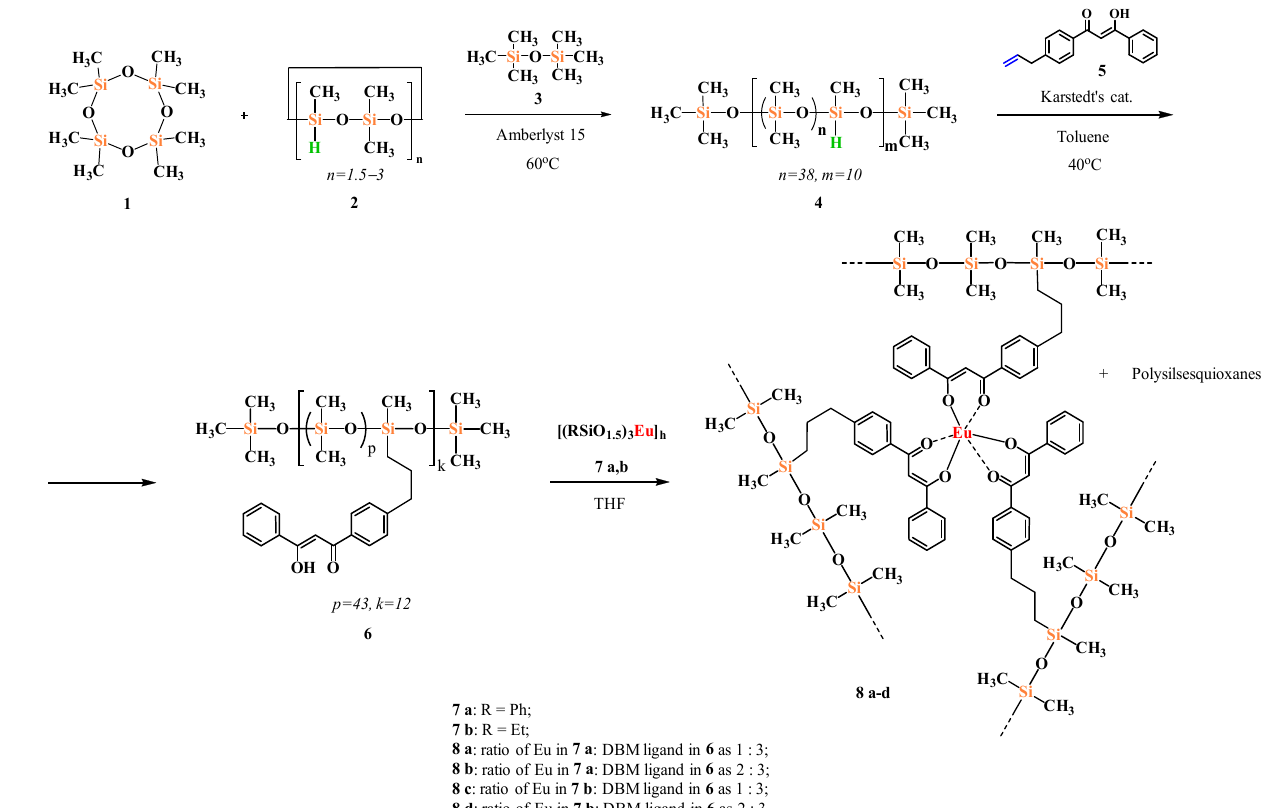
Scheme 1. Preparation of cross-linked polymers 8 a – d based on modified polysiloxane and oligoor- ganoeuropiumsiloxanes.